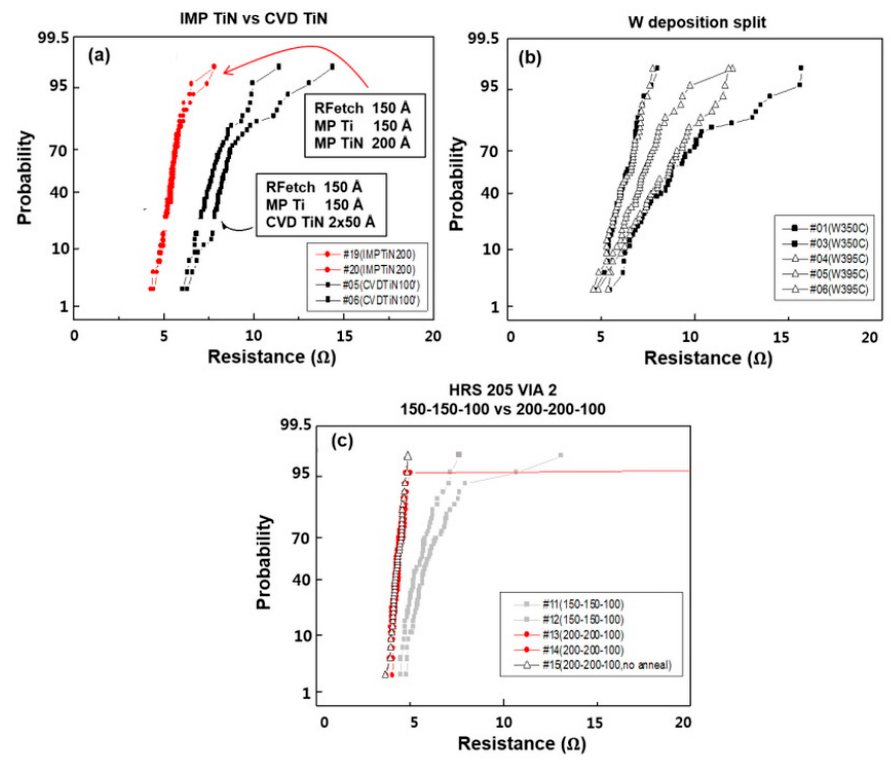
Figure 7. ( a ) Comparison of via resistance between IMP TiN and CVD TiN. ( b ) Comparison of results of change of W deposition temperature 350 °C. ( c ) 015 logic via barrier evaluation of via resistance in deposition conditions. Table 4. Tungsten (W) deposition